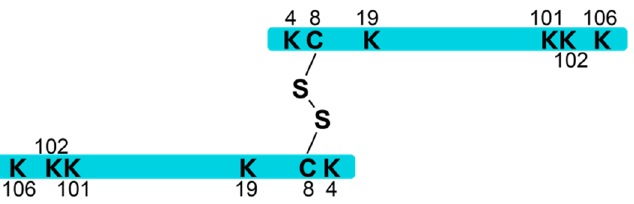
Figure 1. A scheme of RL2 2 . K and C: Lys and Cys, respectively. Numbers indicate the position of the amino acid residues in RL2 sequence. the amino acid residues in RL2